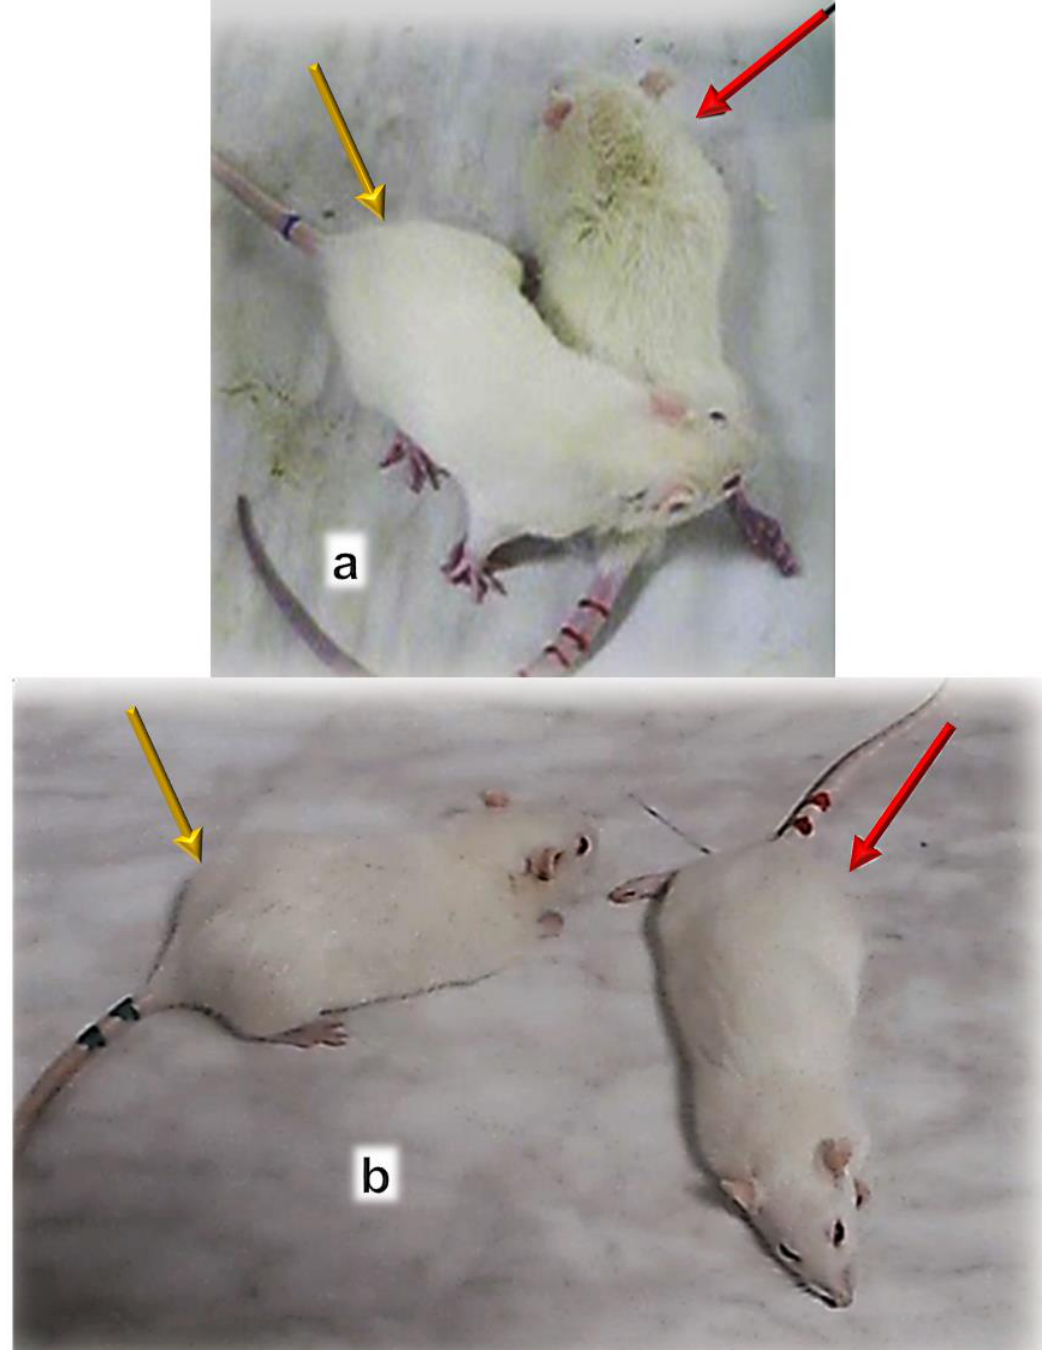
Figure 10. Muscle disability after abdominal aorta anastomosis [129] ( a ). Muscle disability with hypermagnesemia induced by magnesium sulfate (560 mg/kg intraperitoneally) ( b ) [19]. Abdominal aorta anastomosis ( a ). The illustrative control animal unable to walk (red arrow), at 24 h after abdominal aorta anastomosis creation, and illustrative normal walk preserved (BPC 157 given as bath at the abdominal anastomosis immediately after surgery), or quickly recovered (BPC 157 given intraperitoneally at 24 h post-surgery) (yellow arrow). Hypermagnesemia ( b ). Illustrative presentation of control rat, severe muscle weakness leading to complete muscle disability and inability to move (red arrow). BPC 157 treated rats (10 µg, 10 ng/kg intraperitoneally at 15 min before magnesium) continuously maintained a normal appearance, undisturbed muscle function (yellow arrow).